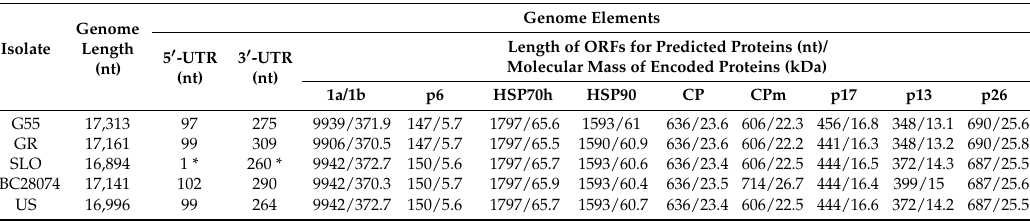
Table 2. Genomic characteristics of the BcLRaV-1 isolates.